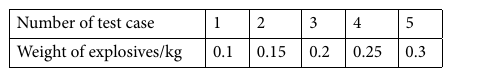
Table 1. Scheme of full-scale field tests.